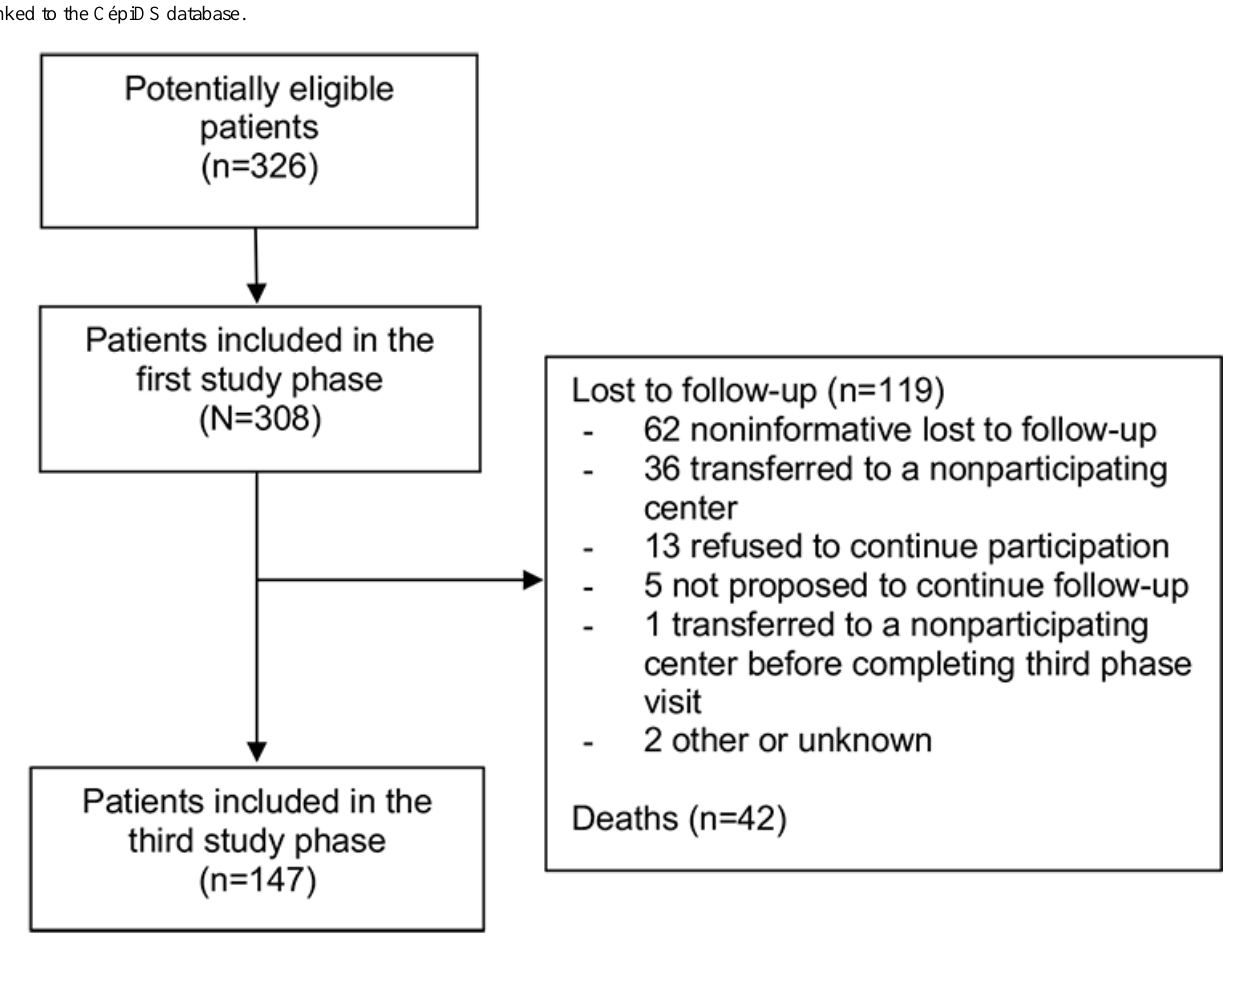
Figure 1. Patient flow. Patient numbers are given between the first and third phases of the French HIV–hepatitis B virus cohort. Reasons for study discontinuation between these phases are also provided. Seven individuals initially considered as lost to follow-up were in fact deceased based on date linked to the CépiDS